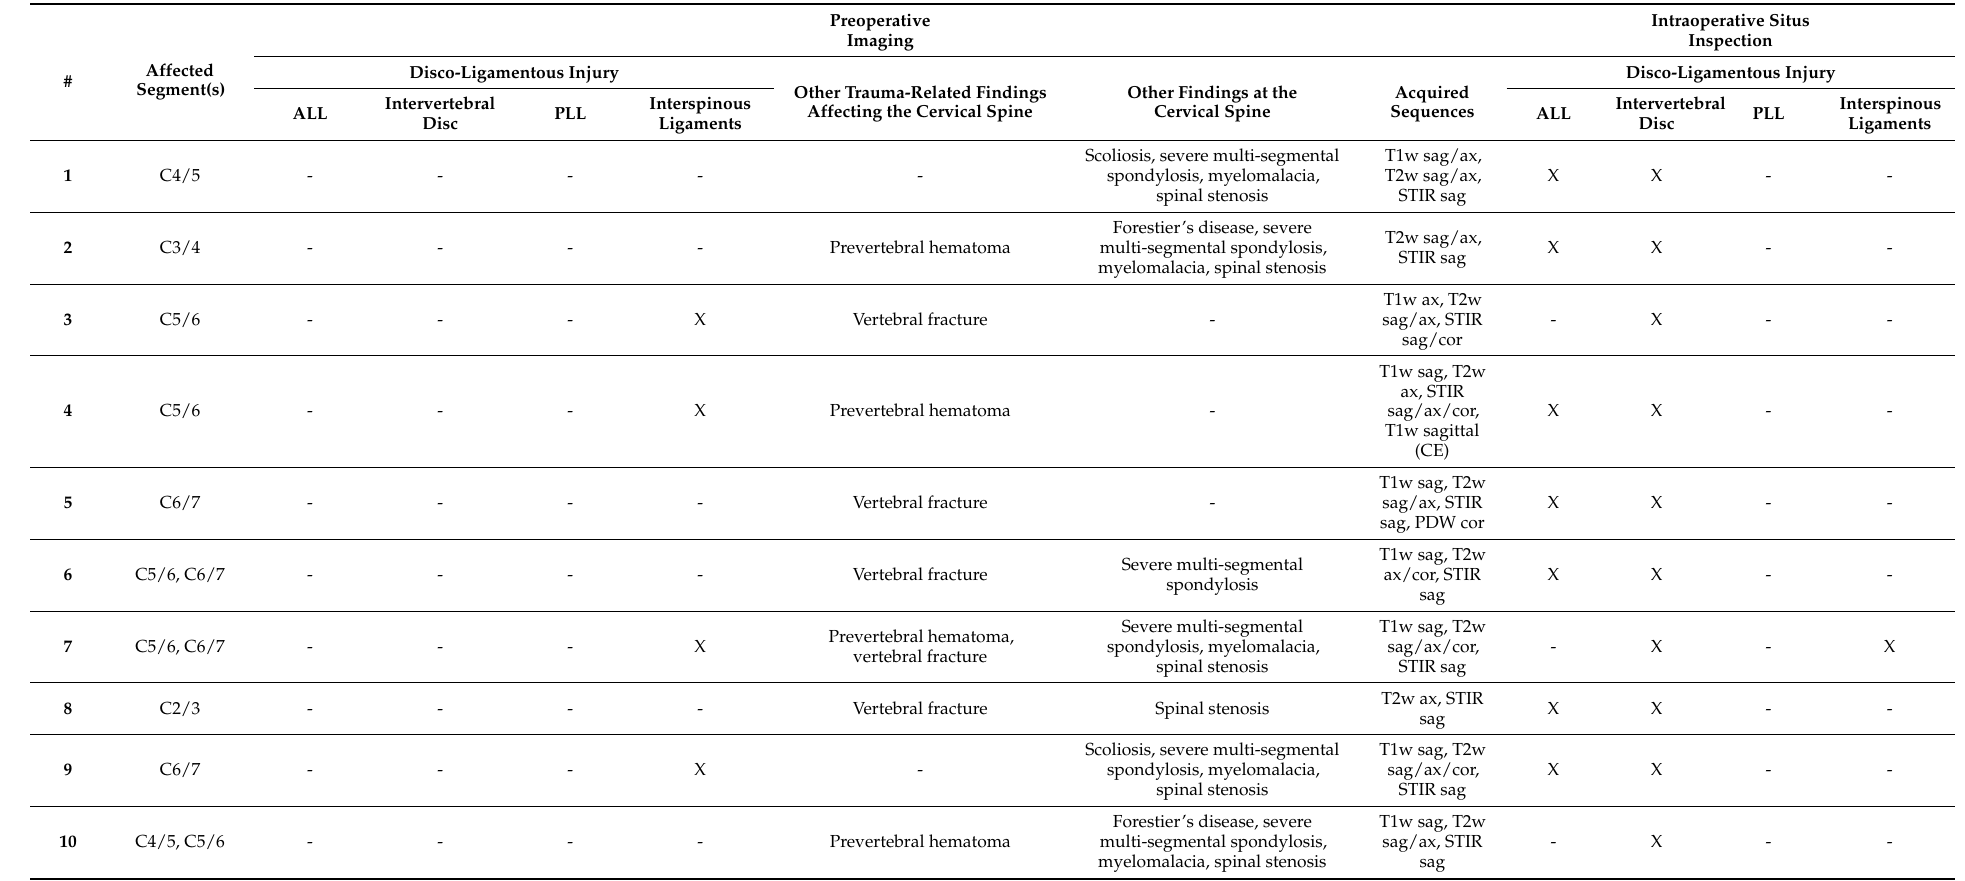
Table 3. Discrepancies between preoperative imaging and intraoperative